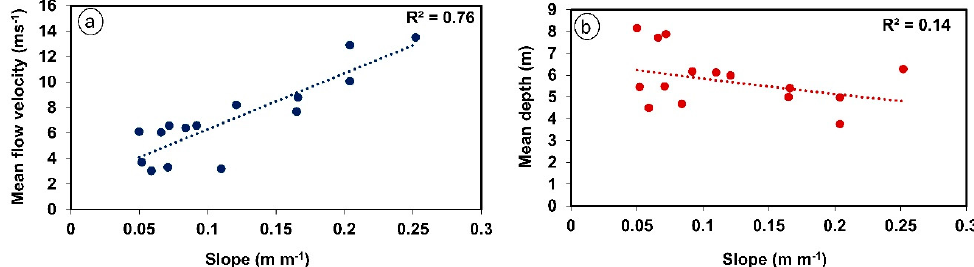
Figure 11. Spatial distribution of maximum flow velocity along the channel from Safed Lake to Milam village for varied Manning’s N—( a ) N = 0.03; ( b ) N = 0.05; ( c ) N = 0.07.